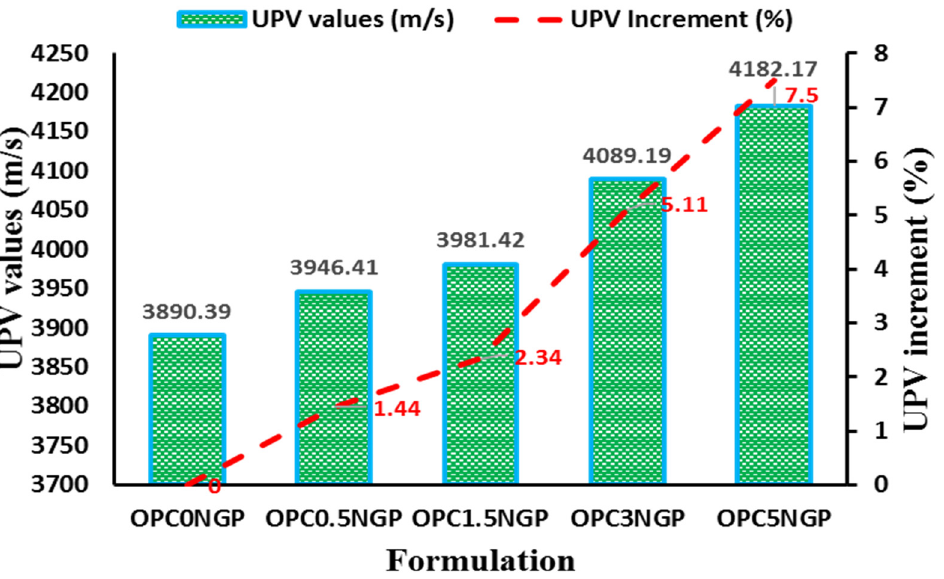
Figure 11. Influence of NGPs on the UPV values.